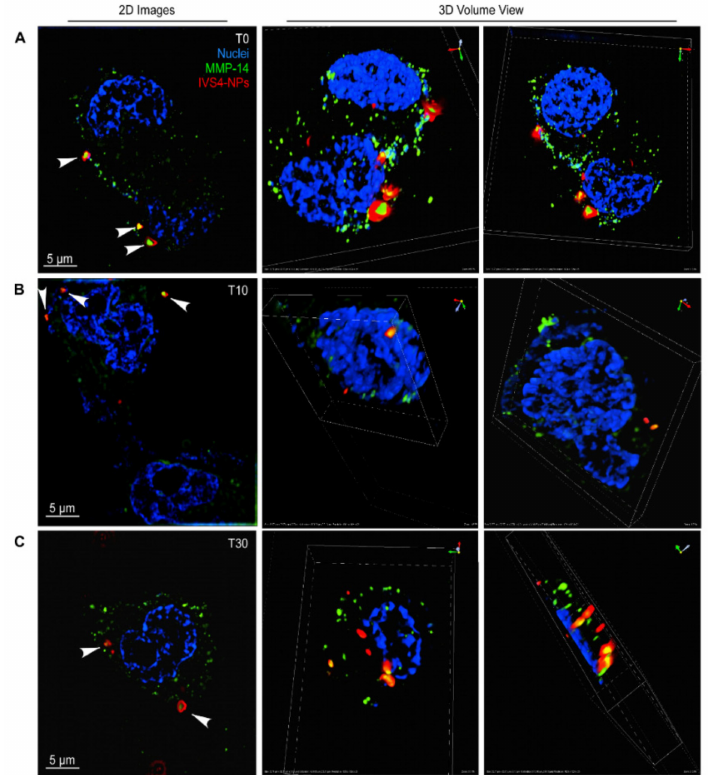
Figure 3. Time-course analysis of IVS4-Cy3-HGC NPs and MMP-14 internalization. ( A ) After an hour at 4 ◦ C, IVS4-Cy3-HGC NPs (red channel) were found to co-localize with MMP-14 (green channel) at the cell surface of MDA-MB-231 cells (T0). ( B ) At T10 min, the NPs and MMP-14 remained co-localized but now appeared to be inside the cell. ( C ) By T30 min, some co-localization was still observed, and the NPs were clearly intracellular and appeared to be perinuclear. Figures on the left-most panel are 2D images, while the right two panels are different 3D views. Arrows indicate areas of MMP-14 and IVS4-Cy3-HGC NP